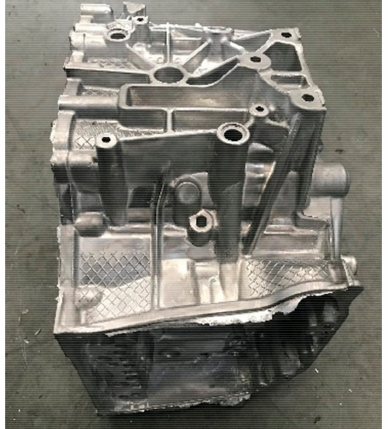
Figure 9. Finished casting drawing.